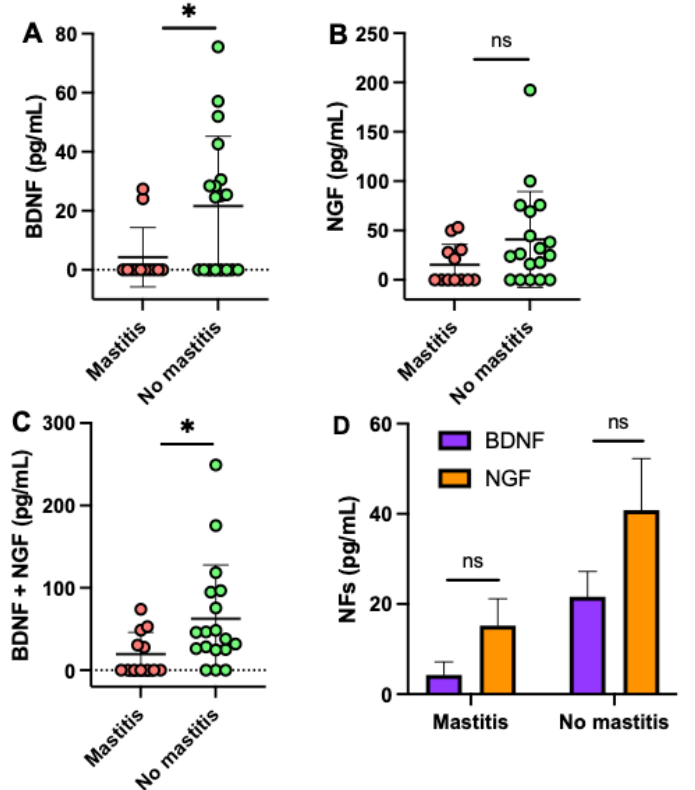
Figure 3. Concentration of brain-derived neurotrophic factor (BDNF) and nerve growth factor (NGF) in human milk from mothers with mastitis and mothers without mastitis. Comparison of ( A ) BDNF, ( B ) NGF, and ( C ) BDNF+NGF between mastitis ( n = 12) and no mastitis groups ( n = 18). ( A – C ) Values are means ± SD, where Mann–Whitney test was used to compare the two groups. ( D ) Values are means ± SD, where Š í d á k’s multiple comparisons test was used to compare BDNF and NGF in each group. Asterisk shows statistically significant differences between groups (* p < 0.05). ns, not significant. Women with mastitis had redness, swelling, and pain in breast, fever, and fatigue. The elapsed time from mastitis to milk collection was 1 to 4